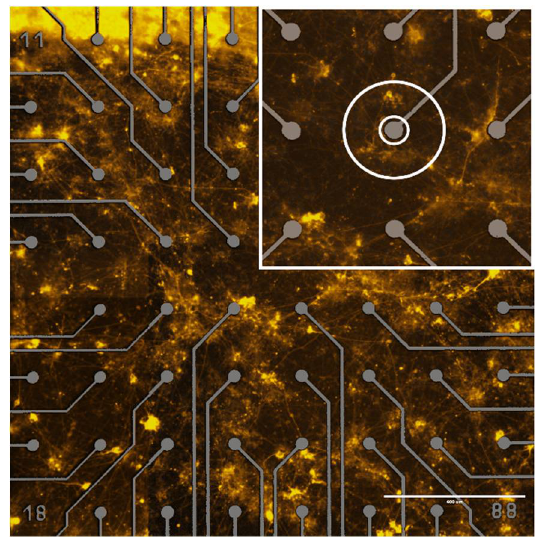
Figure 4. Fluorescence image of the electrode area of a multielectrode array with an adherent random network of human stem-cell-derived neurons. The inset in the top right-hand corner exemplarily shows a magnified electrode as well as the maximum and typical signal recording distance of a single electrode as indicated by the concentric white circles. A single electrode can therefore record extracellular electrical signals from more than one neuron. The bright area at the top of the picture is a folding region of detached neurons. Scale bar, 400 µm.